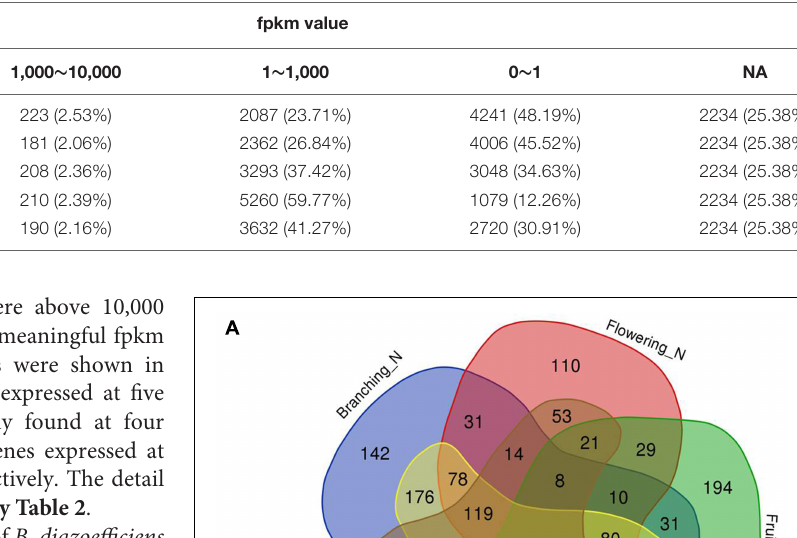
TABLE 1 | The numbers of B. diazoefficiens 113-2 genes in different fpkm value groups in five nodule samples.